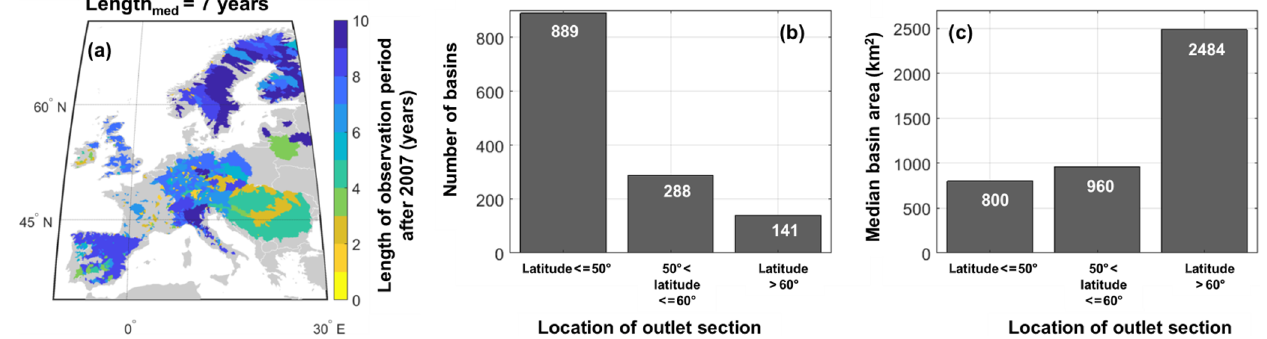
Figure 1. Location of study basins and length of discharge observation period after 2007 (a) . Number of basins (b) and median basin area (c) clustered according to the latitude coordinate of the outlet section of the basins. Table 1. Main characteristics of the data sets used in this